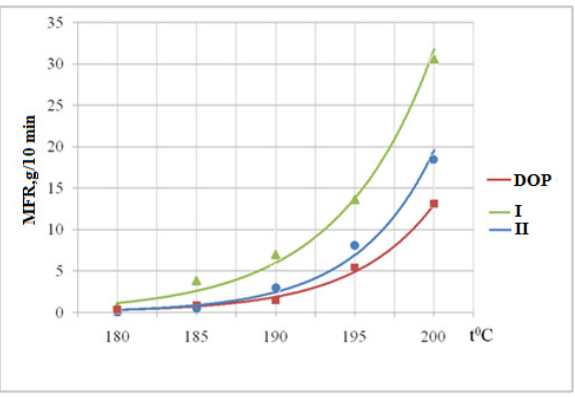
Figure 11. Dependence of the MFR of PVC composition on temperature. I–II—Symbols of plasticizers (Table 1).